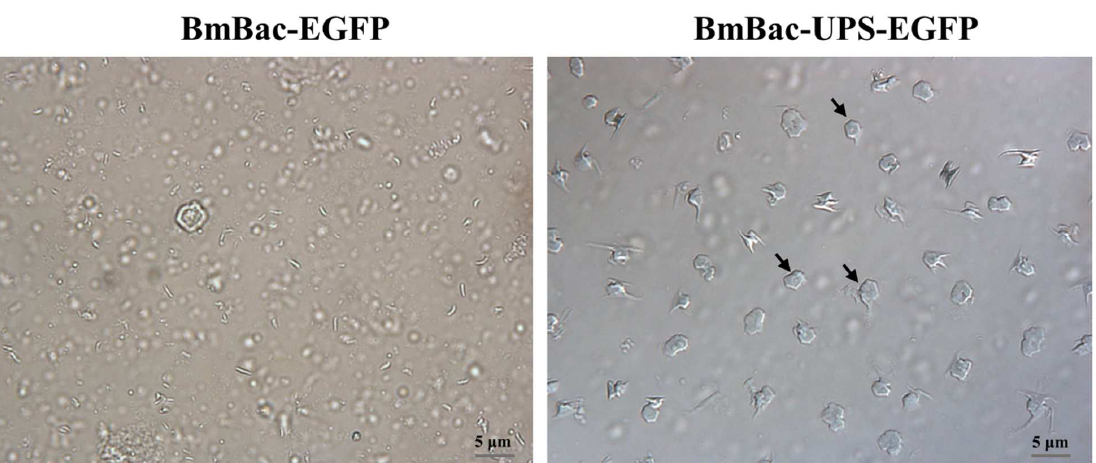
Figure 6. Detection of occlusion body in the transgenic BmN cells infected with BmBac-UPS-EGFP and BmBac-EGFP. Virus-infected cell lysates were visualized by microscopy at 120 h after infection under visible bright light. The scale bars in the visible images represent 5 μm. Some of the inclusion bodies are indicated by arrowheads.